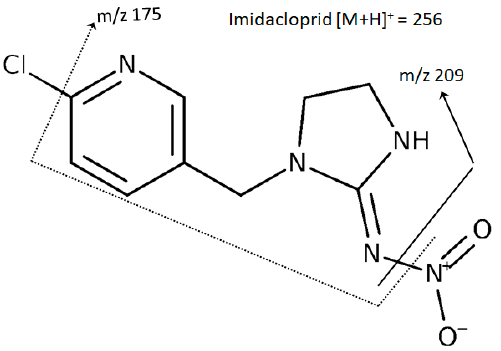
Figure 2. Profile of fragmentation of the insecticide imidacloprid obtained in the optimization of the HPLC-MS/MS method.